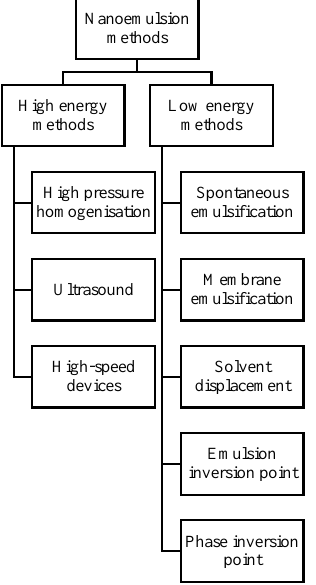
Figure 1. Methods for preparation of nanoemulsions.